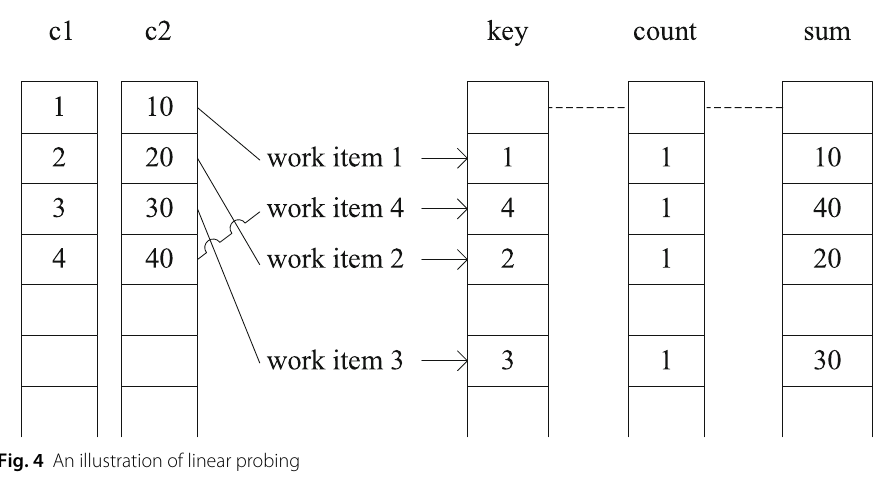
Fig. 4 An illustration of linear